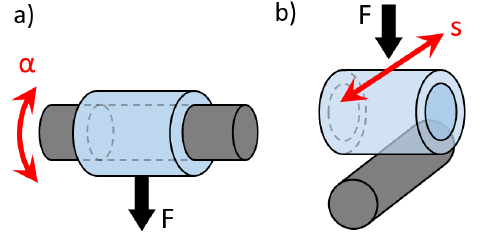
Figure 5. Chain specimen configurations on tribometer: a) pin-in-bush, b) bush-on-pin